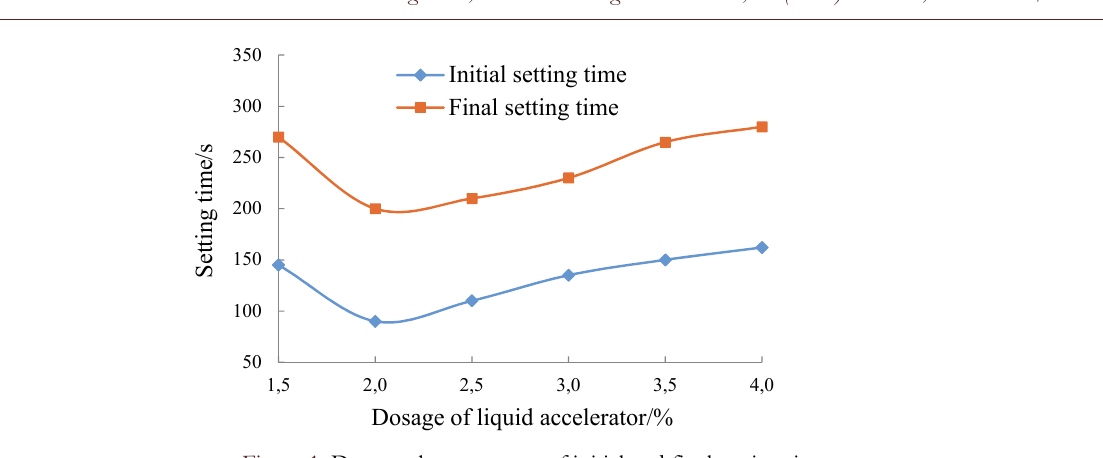
Figure 1: Dosage change curves of initial and final setting time